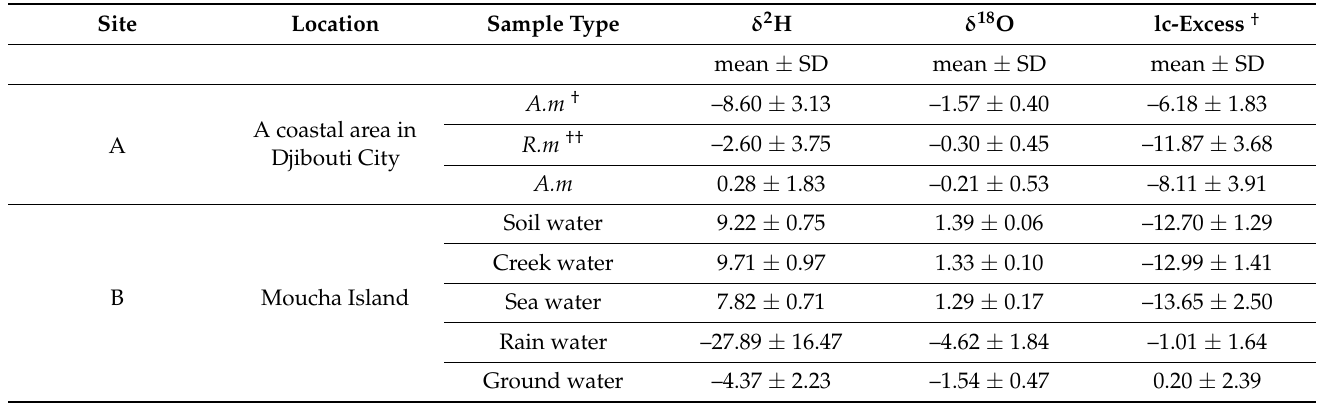
Table 1. The mean ± standard deviation value of δ 2 H, δ 18 O and line-conditioned excess (lc-excess) in environmental water and plant body water (units: ‰).